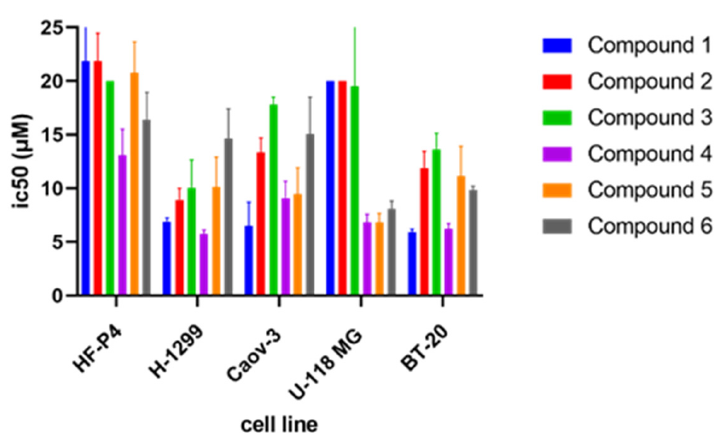
Figure 9. IC 50 values of compounds 1 – 6 on HF-P4 (human fibroblast), H-1299 (human NSCLC), Caov-3 (human ovarian cancer), U-118 MG (human brain glioma), and BT-20 (breast cancer) cell line. Table 3. IC 50 values of compounds 1 – 6 on HF-P4, H-1299, Caov-3, U-118, and BT-20 cell lines.